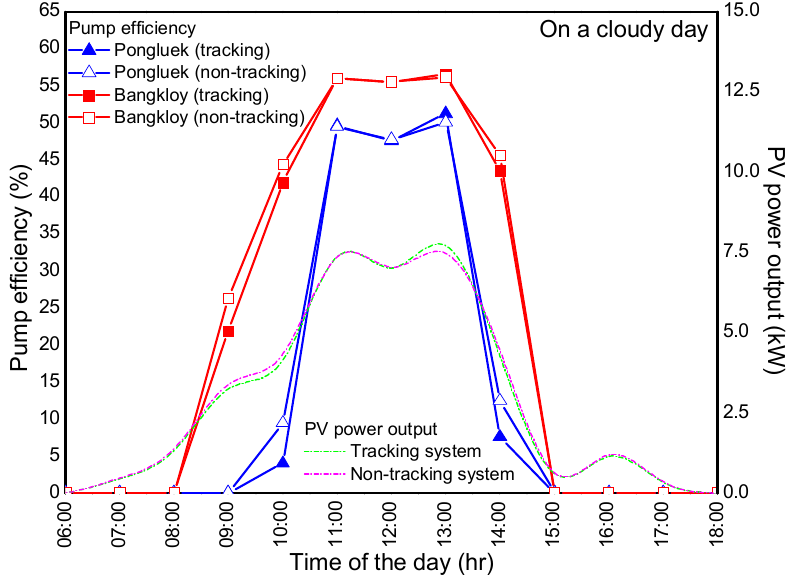
Figure 16. Water flow rate of the pumps at Pongluek and Bangkloy according to the PV power output on a cloudy day for tracking and non-tracking SWSS.